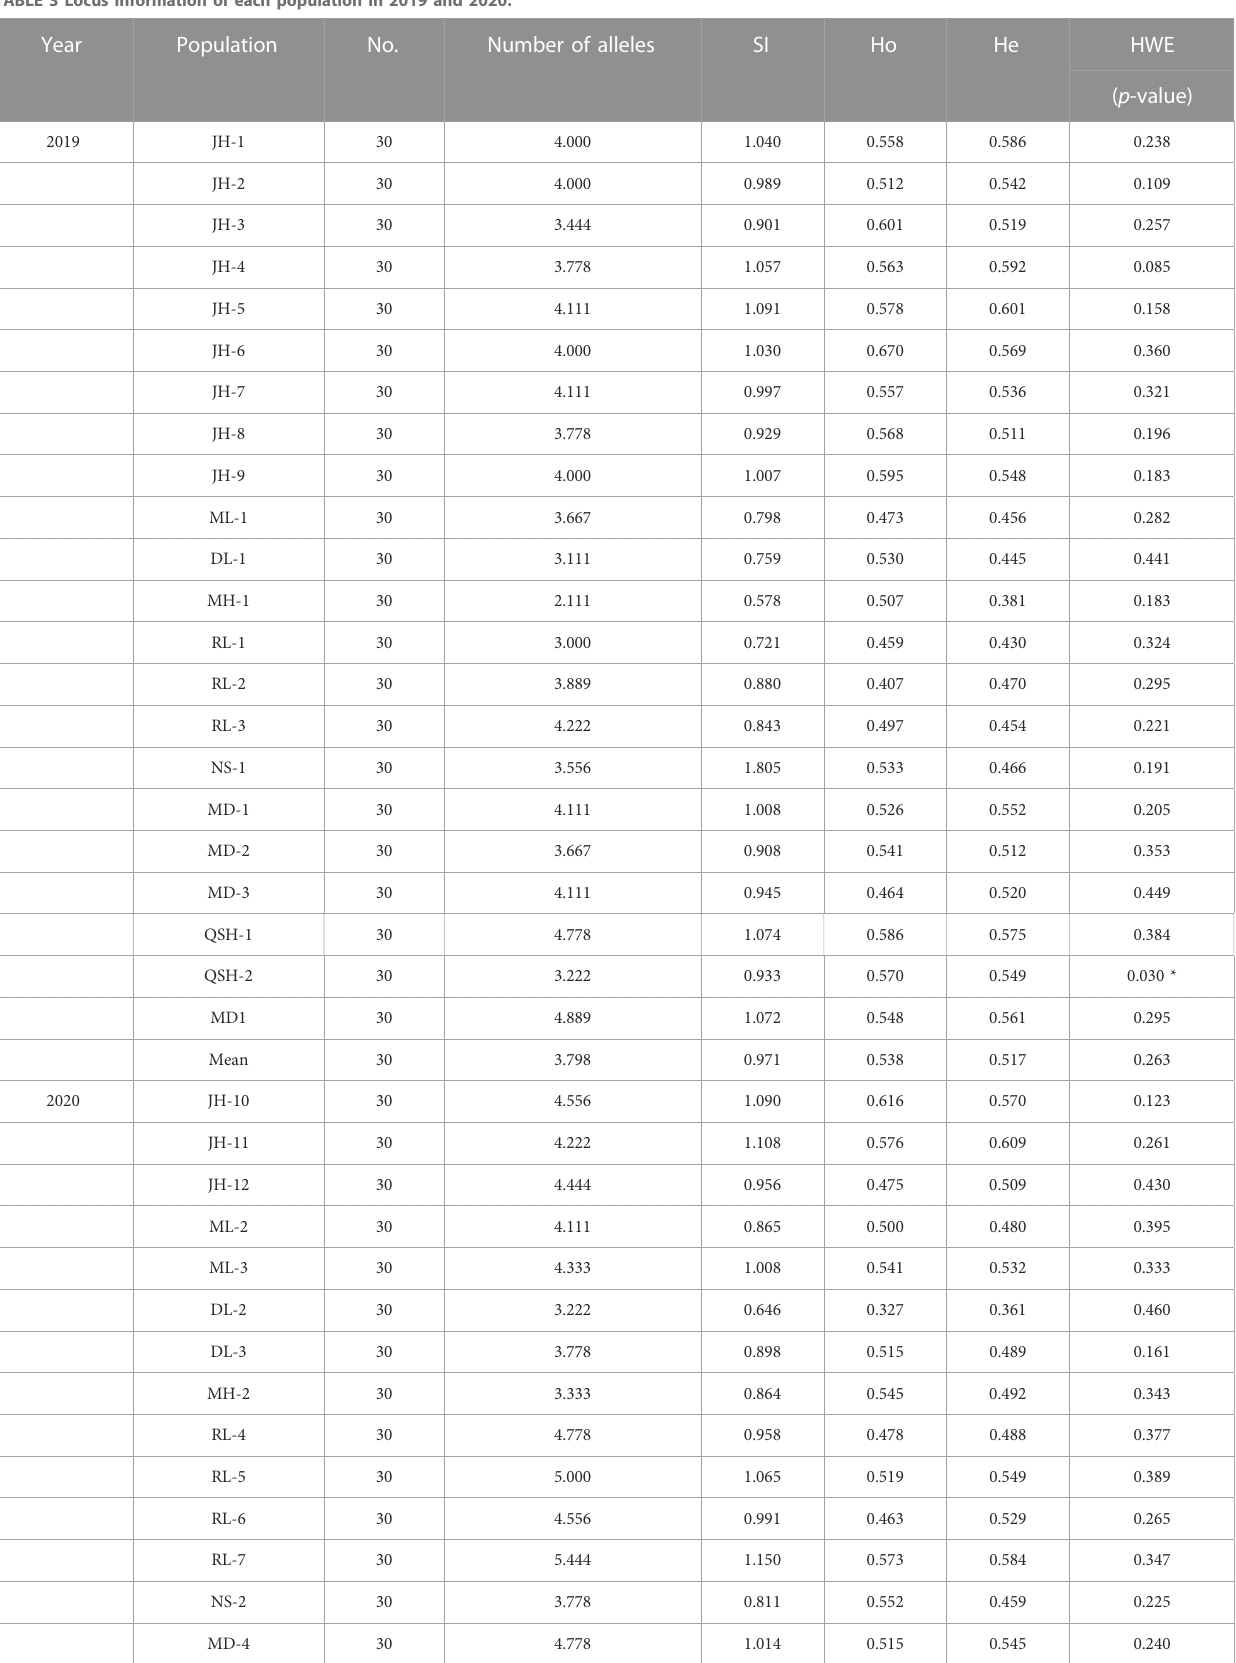
TABLE 3 Locus information of each population in 2019 and 2020. Year Population No. Number of alleles SI Ho He HWE